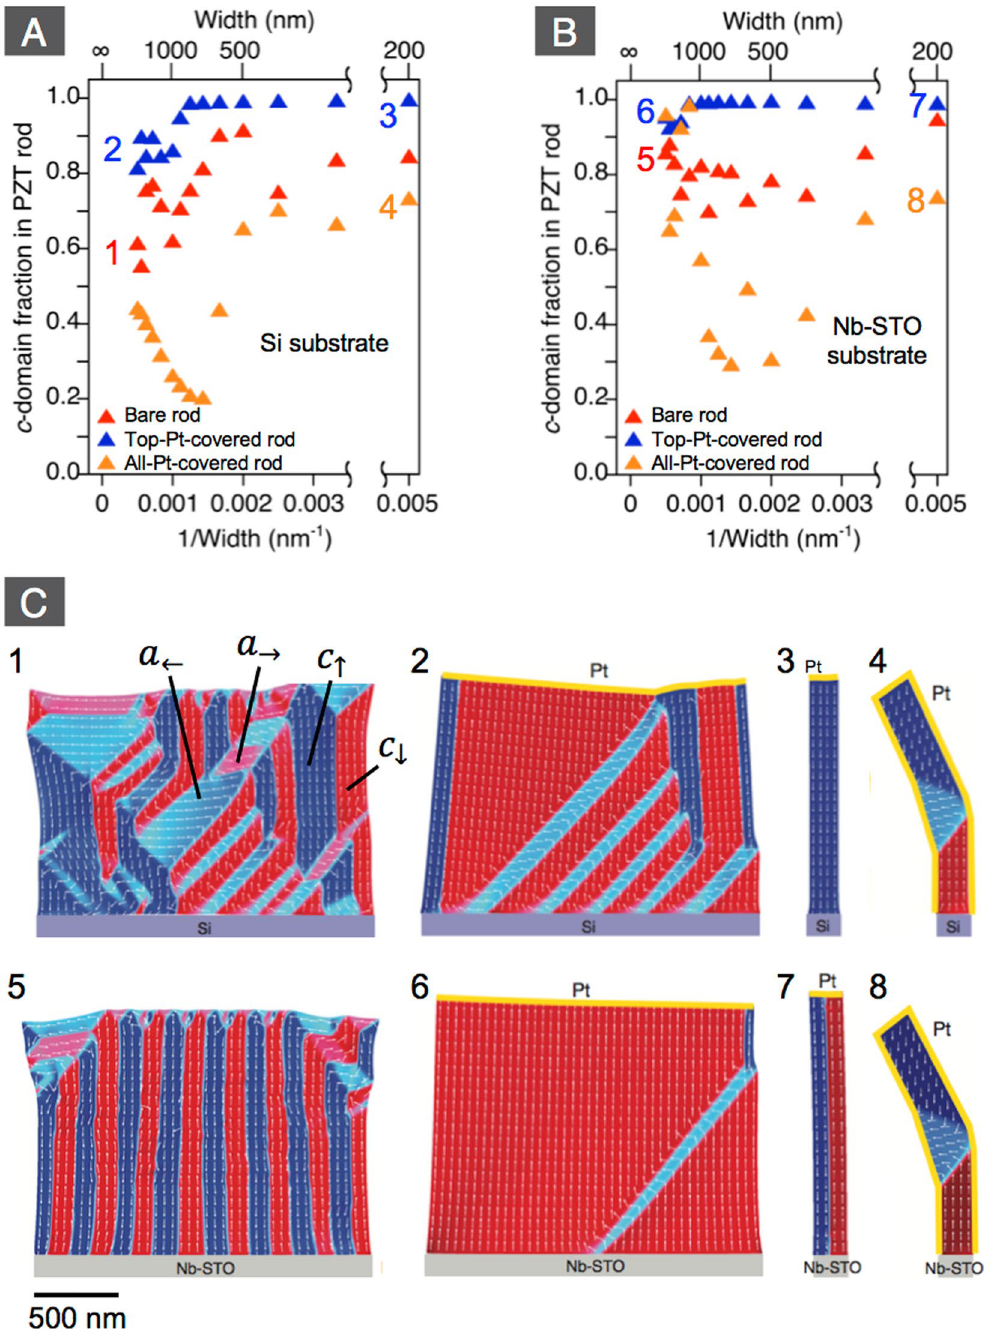
Figure 7. Calculated c -domain fraction of PZT rods on Si ( A ) and Nb-STO ( B ) by phase-field simulation. Red, blue, and orange triangles respectively show bare rods, rod with top Pt-surface, and rod covered with Pt on both top and sidewall surfaces. The numbers shown in ( A ) and ( B ) correspond to those in ( C ). ( C ) Calculated domain patterns of 2 µ m wide rods with bare top surface on Si (1) and on Nb-STO (5), of 2 µ m wide rods with top Pt-surface on Si (2) and Nb-STO (6), of 200 nm wide rods with top Pt-surface on Si (3) and Nb-STO (7), and of 200 nm wide rods with both top Pt surface and sidewall Pt surface on Si (4) and on Nb-STO